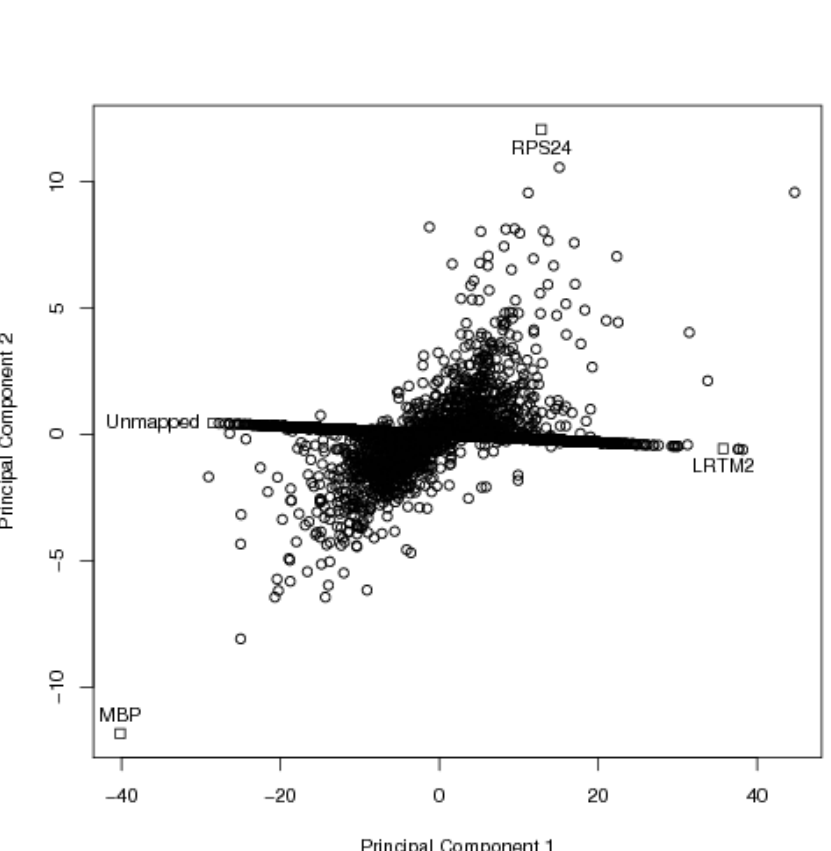
Figure 4 – Functional principal components analysis loadings plot. Two functional principal components capture 99.9% of the observed variation in the fitted mean curves for each gene. The loadings on the first principal component function corresponds to the x-axis, which represents linear variation over time. The second principal component function captures variation which is of a more quadratic nature. These two principal component functions are given in Figure 6. Four outliers representing the spectrum of observed temporal profiles have been highlighted; individual plots for these genes are given in Figure